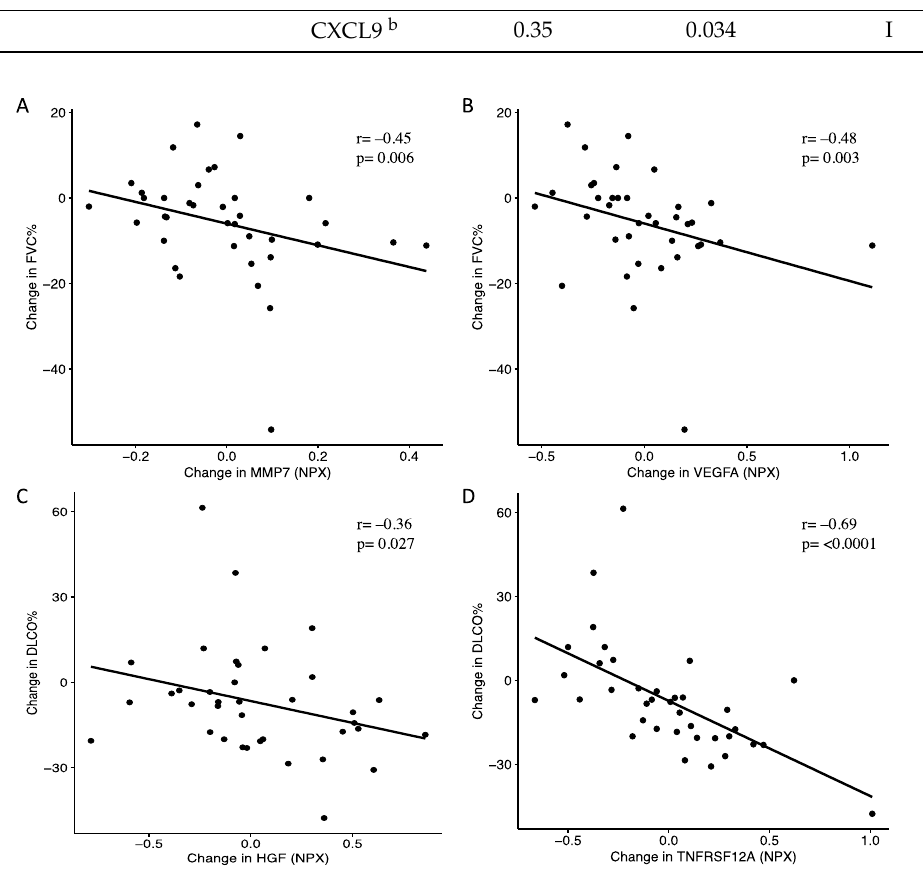
Figure 4. Elevated levels of MMP7, VEGFA, HGF and TNFRSF12A were associated with declining lung function. Increasing MMP7 and VEGFA correlated with decline in forced vital capacity (FVC %) ( A , B ), while HGF and TNFRSF12A were associated with decline in diffusing capacity (DLCO %) ( C , D ). p and r values were determined using Spearman rank correlation method.